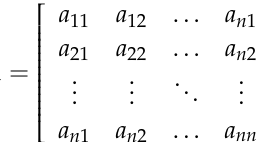
Table 1. Scale reference for indicators.